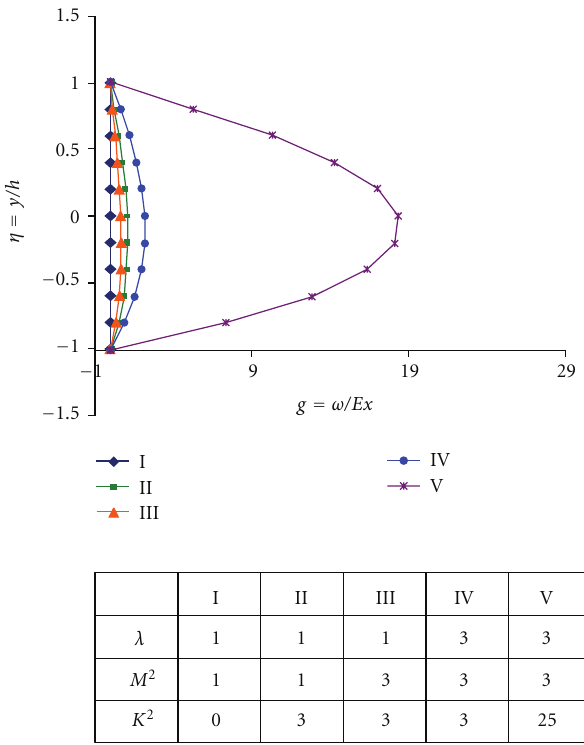
Figure 4: Velocity profile for g (cid:7) R (cid:6) 0 . 1, N (cid:6) 10 (cid:8)